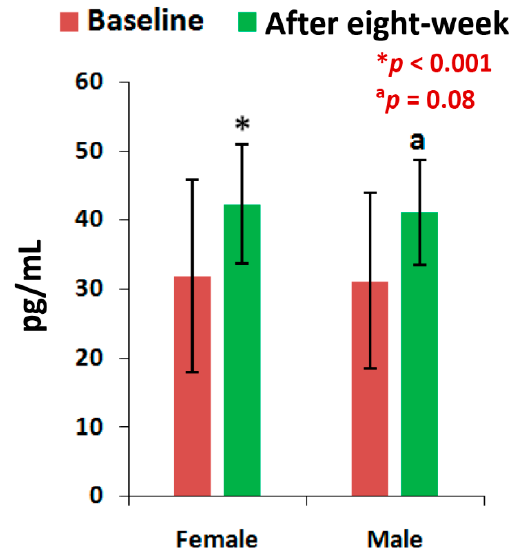
Figure 3. Levels of Parathyroid hormone of 63 experimental subjects, female ( n = 39) and male ( n = 24), before and after eight ‐ week using supplement (* p < 0.001, ᵃ p = 0.08).